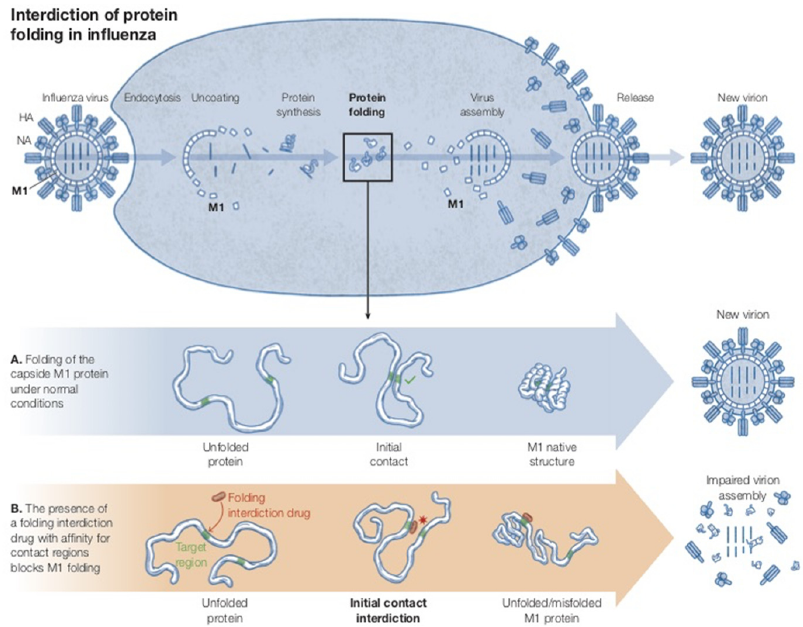
Figure 1. Illustration of the FITR strategy aimed to disrupt viral assembly by targeting critical structural proteins; the case of influenza protein A is depict e d.